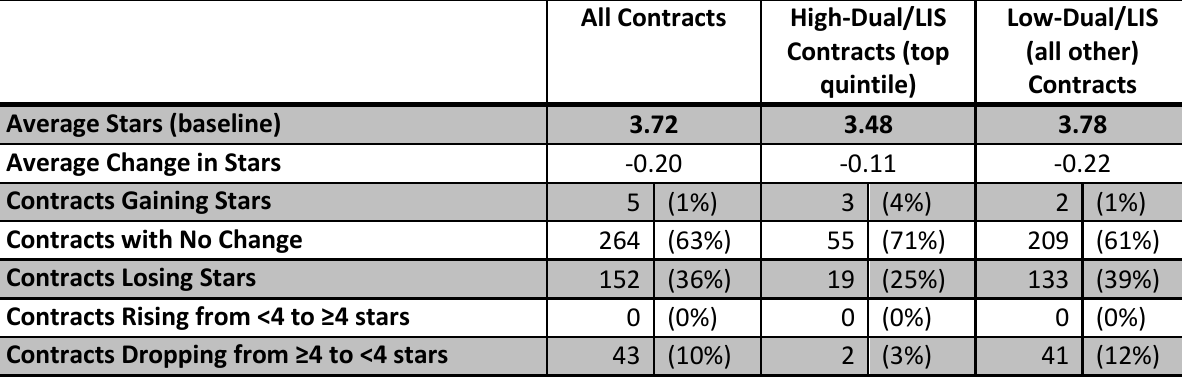
Table 8.11: Adjusting Quality Star Ratings using Contract-Level